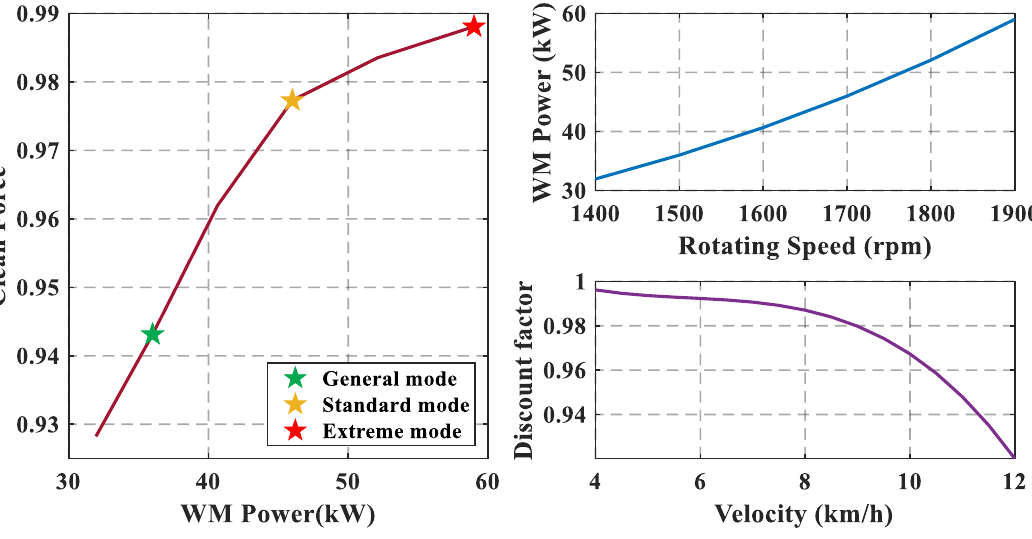
Figure 10. Power requirement model of the working motor.